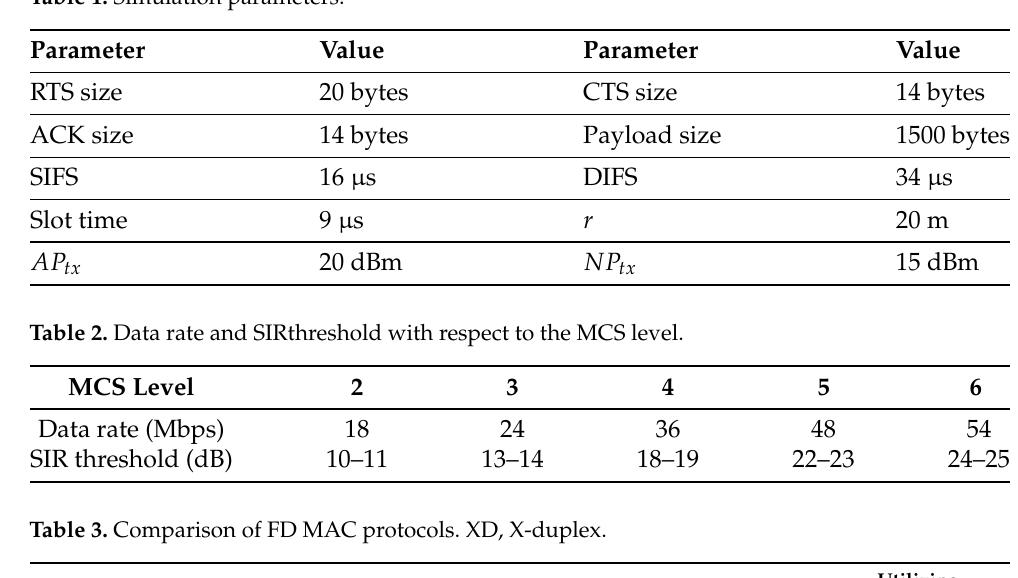
Table 1. Simulation parameters.